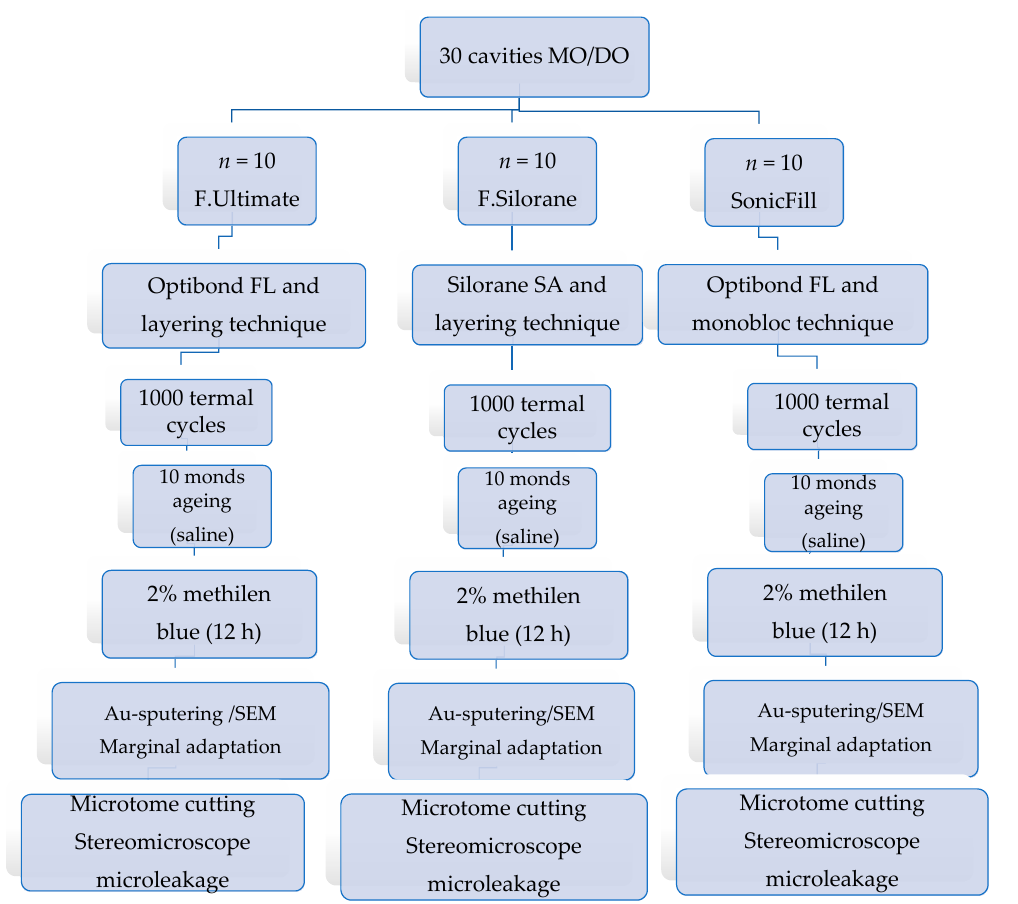
Figure 1. Schematic representation of the overall experimental design used in the study.